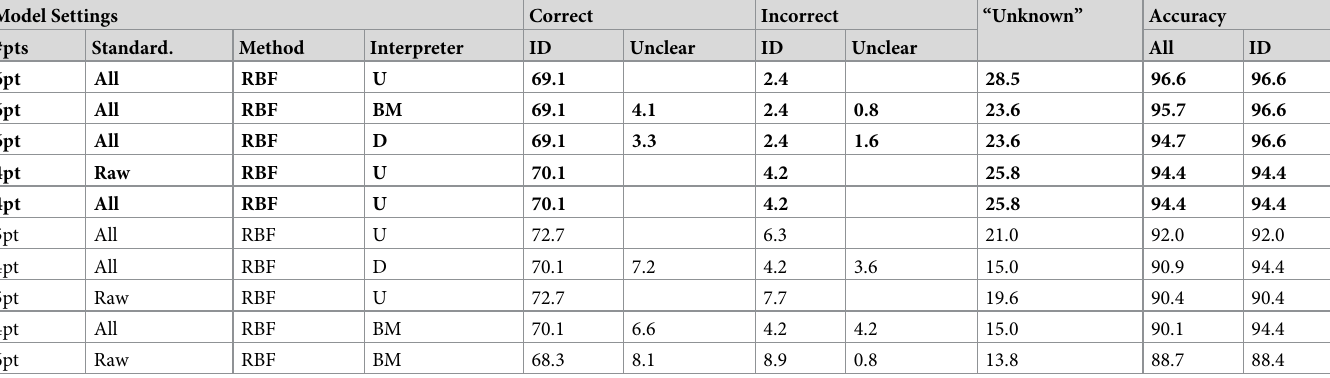
Bold Models are shared with Table 5. Numbers represent percentages. For Interpreter, U is defined as “Unanimous”, BM as “Best Match”, and D as “Dominant”.